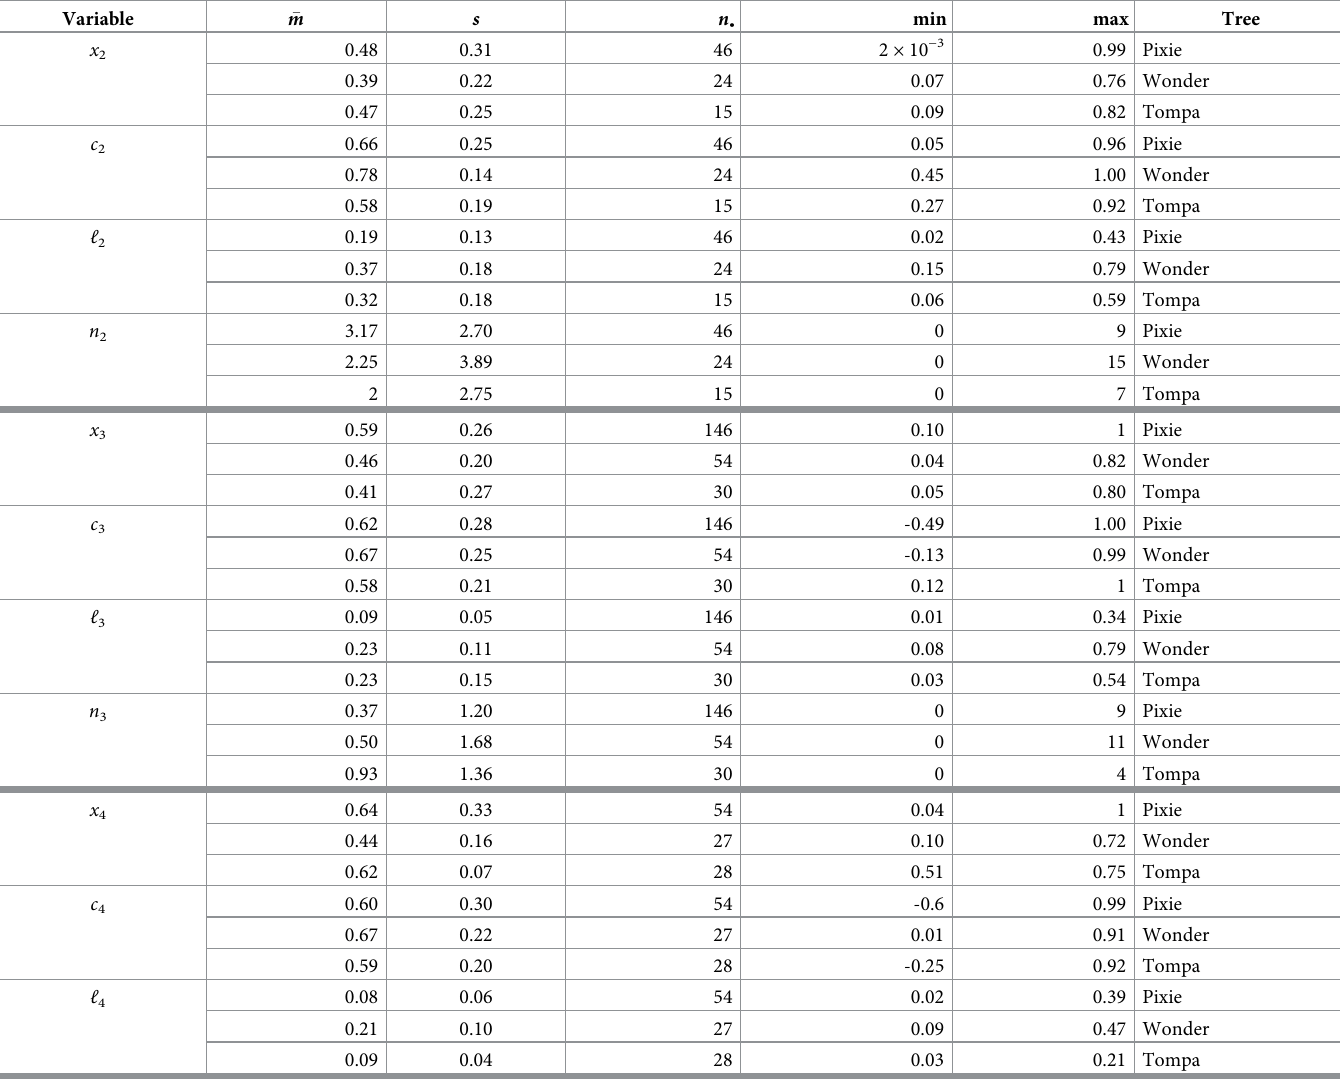
Table 3. Summary statistics of Pixie Tree, Wonder Tree and Tompa Tree (in this order, from top to bottom in each cell of the table) for the variables defined in Table 2.